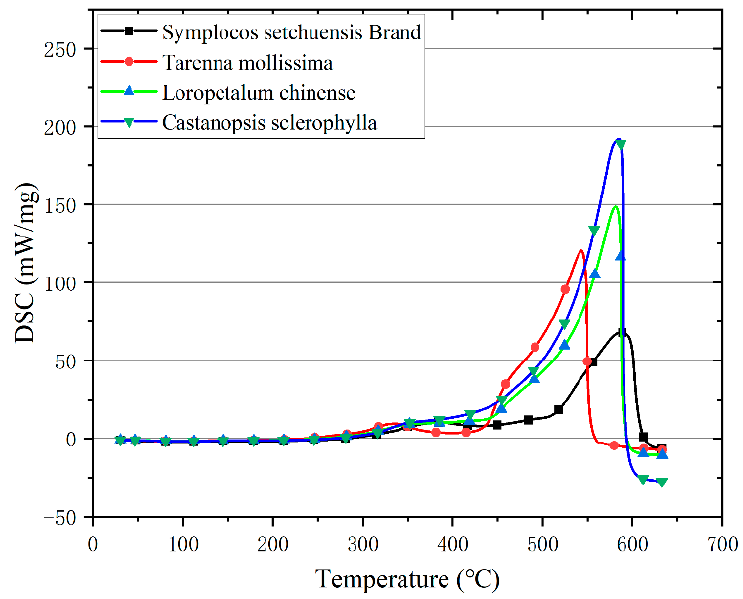
Figure 4. Results of DSC analysis of four samples.